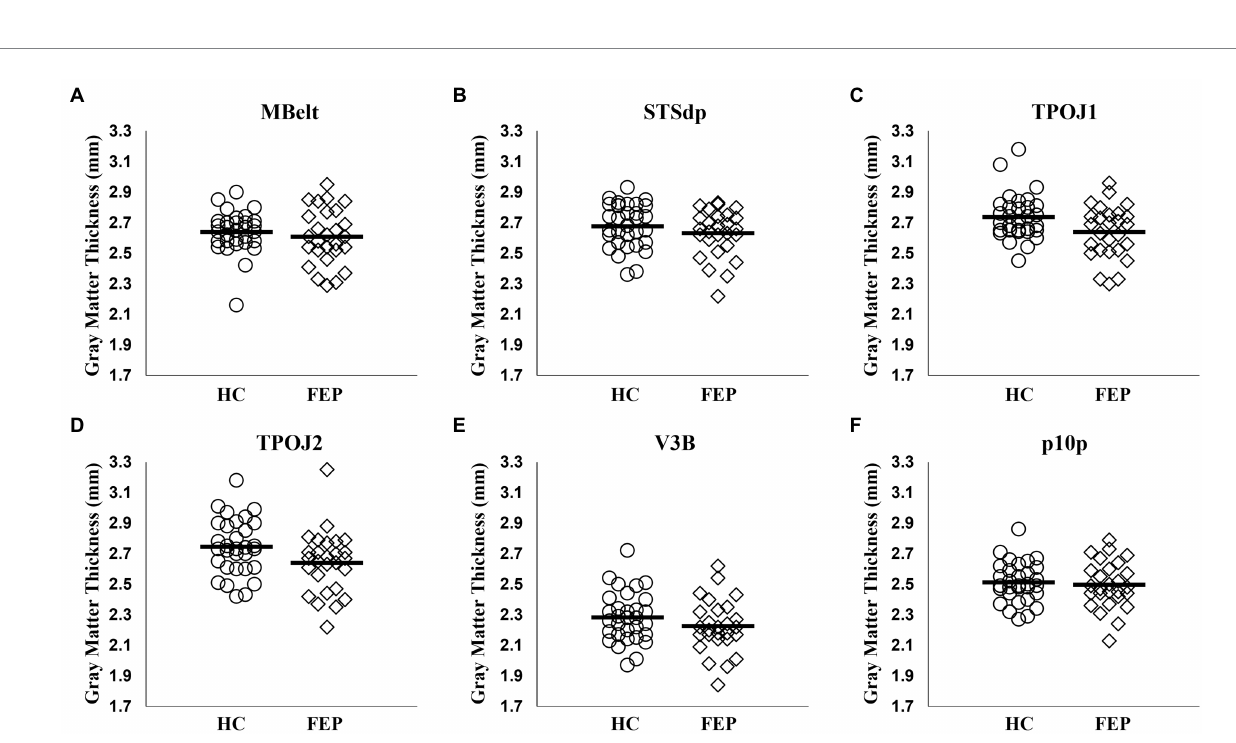
FIGURE 9 Gray matter thickness in the left hemisphere attention network. Compared to healthy controls, individuals with first-episode of psychosis (FEP) showed significant reductions in gray matter thickness across the regions in the left hemisphere precuneus attention network ( p < 0.05; A–F